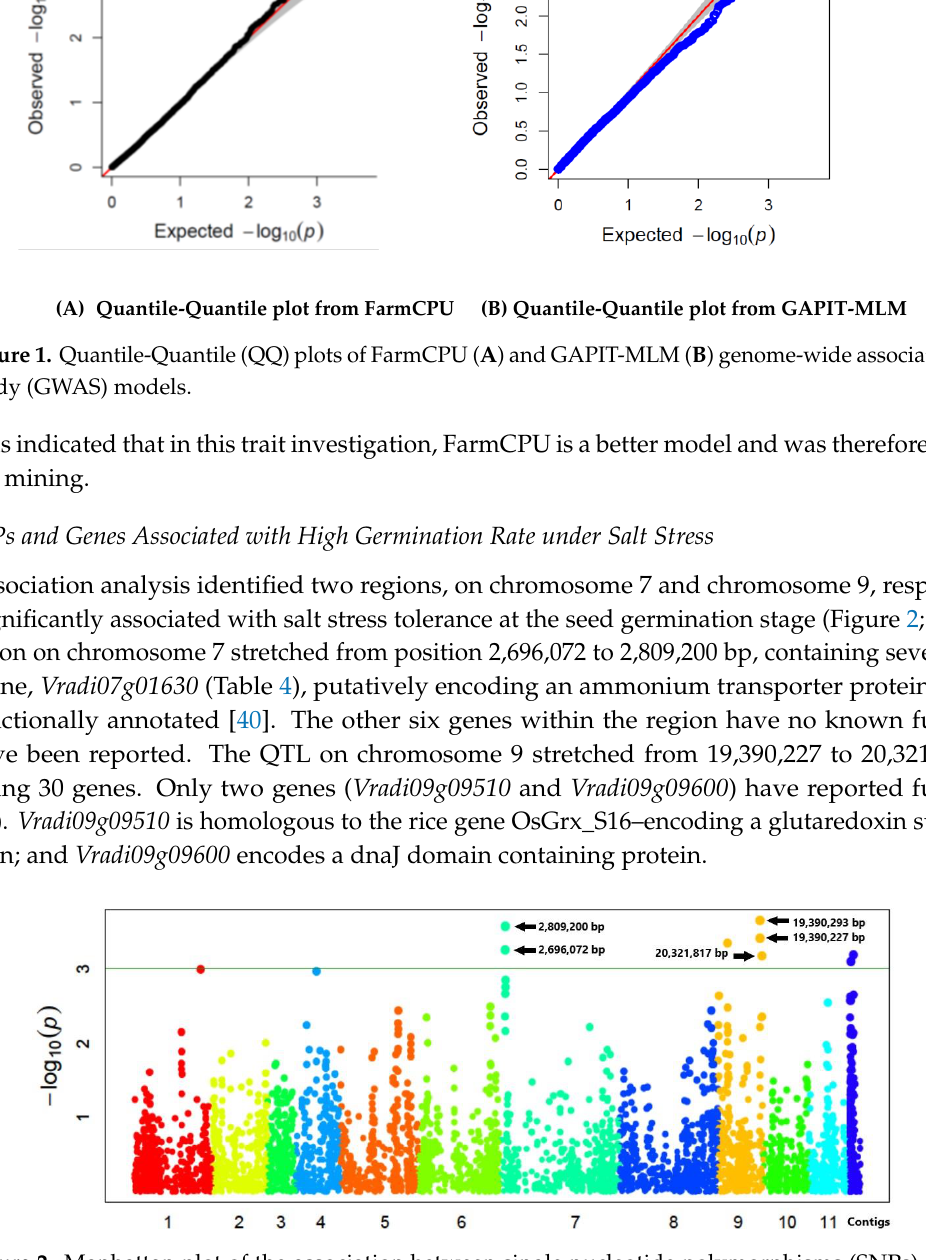
Figure 2. Manhattan plot of the association between single nucleotide polymorphisms (SNPs) and germination percentage of minicore collection accessions. Table 4. SNP logarithm of the odds (LOD) scores, associated regions and gene homologs based according to the annotation given by Kang et al. (2014) [41] .